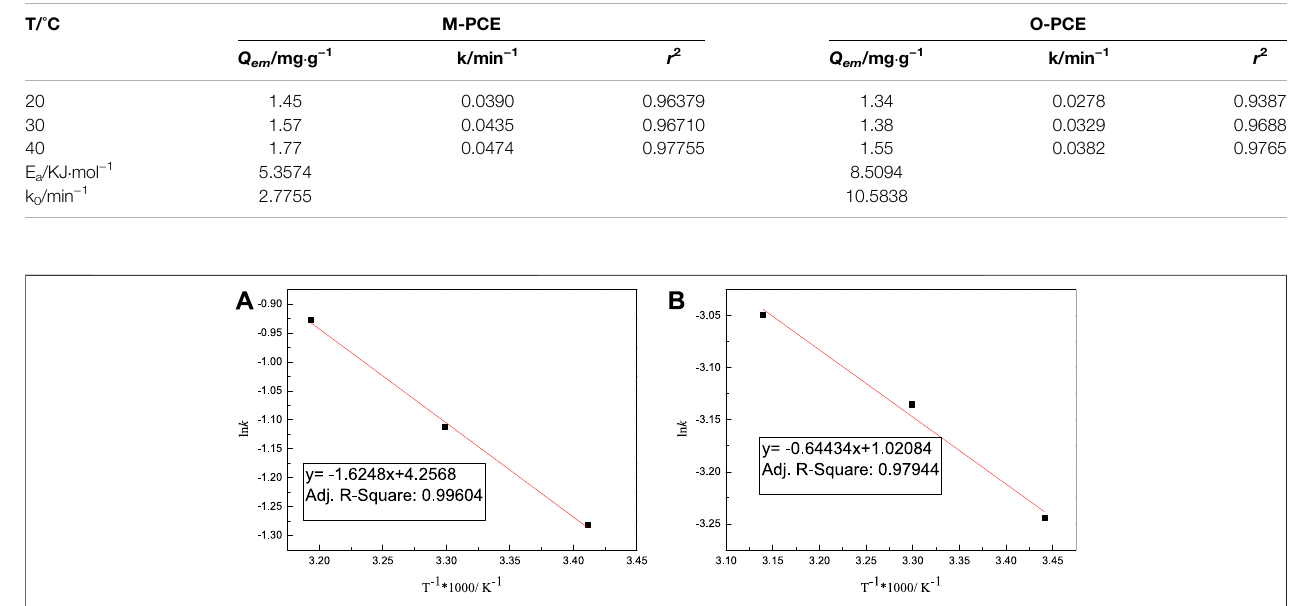
FIGURE10 | Determination result of activation energy of adsorption of PCE: (A) M-PCE and (B) O-PCE.